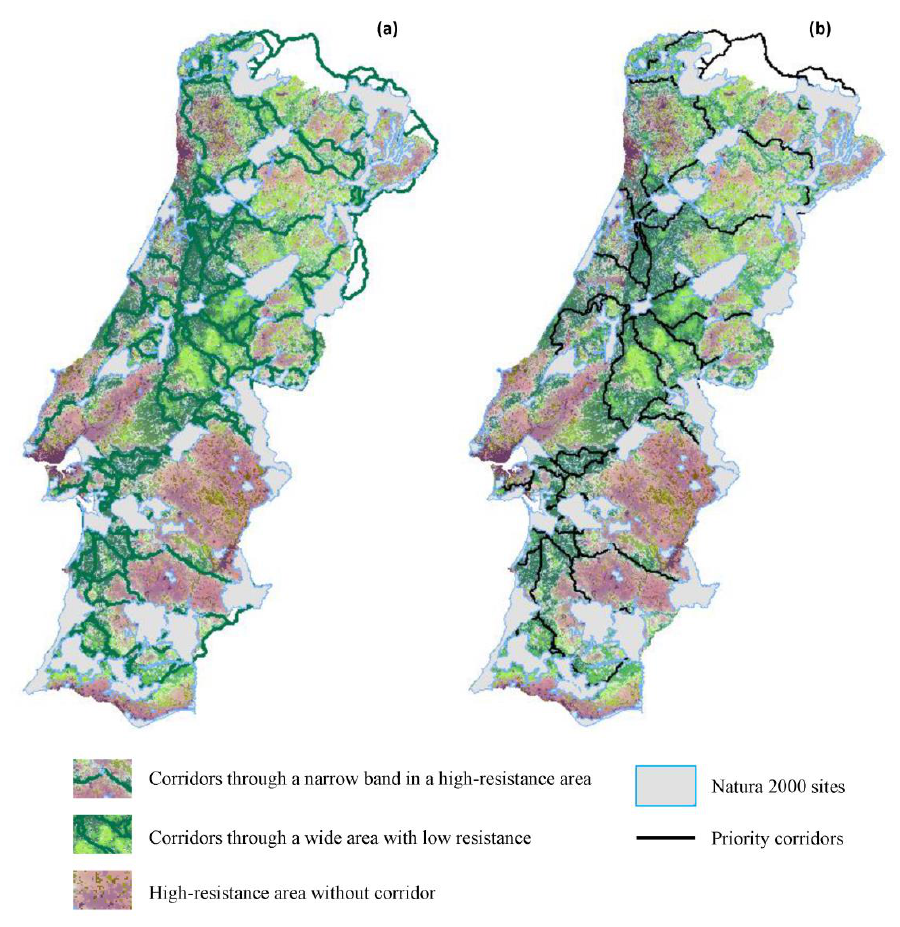
Figure 3. Corridors of variable width between the Natura 2000 forest sites ( a ) and central axes of the priority corridors for maintaining the connectivity of the Natura 2000 forest network ( b ) in mainland Portugal. Land suitability for corridors is shown ranging from high (dark green) to low (violet). About 19% of the identified corridors were covered by purely coniferous forests in Portugal. Of